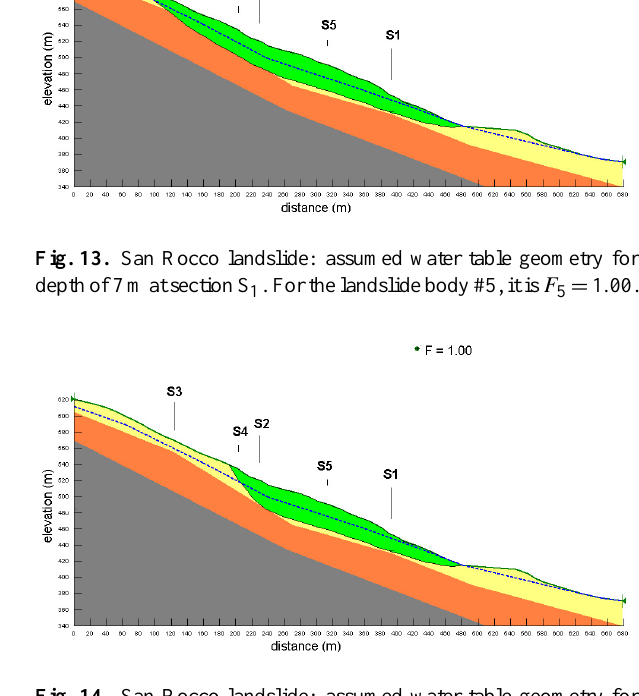
Fig. 14. San Rocco landslide: assumed water table geometry for